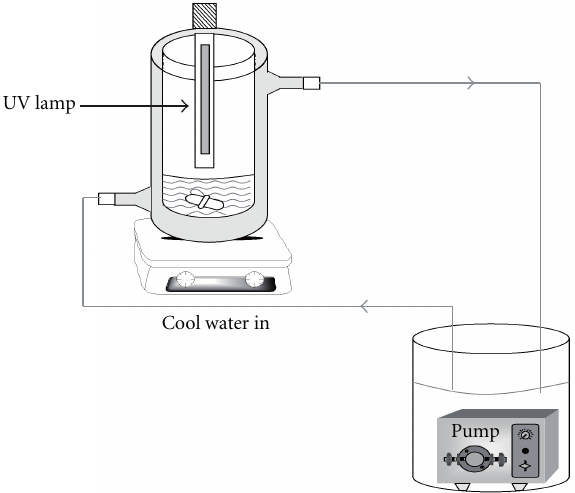
F 1: Schematic diagram for batch photoreactor.